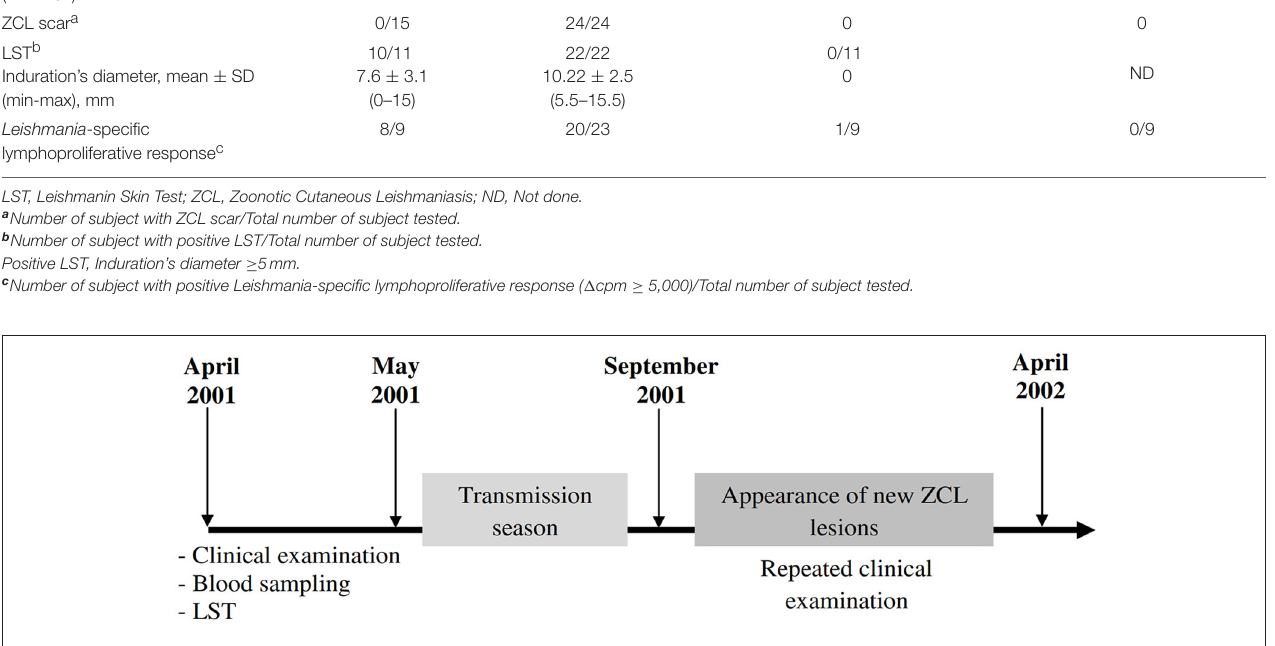
Healthy subjects living outside endemic area ( n = 9 )